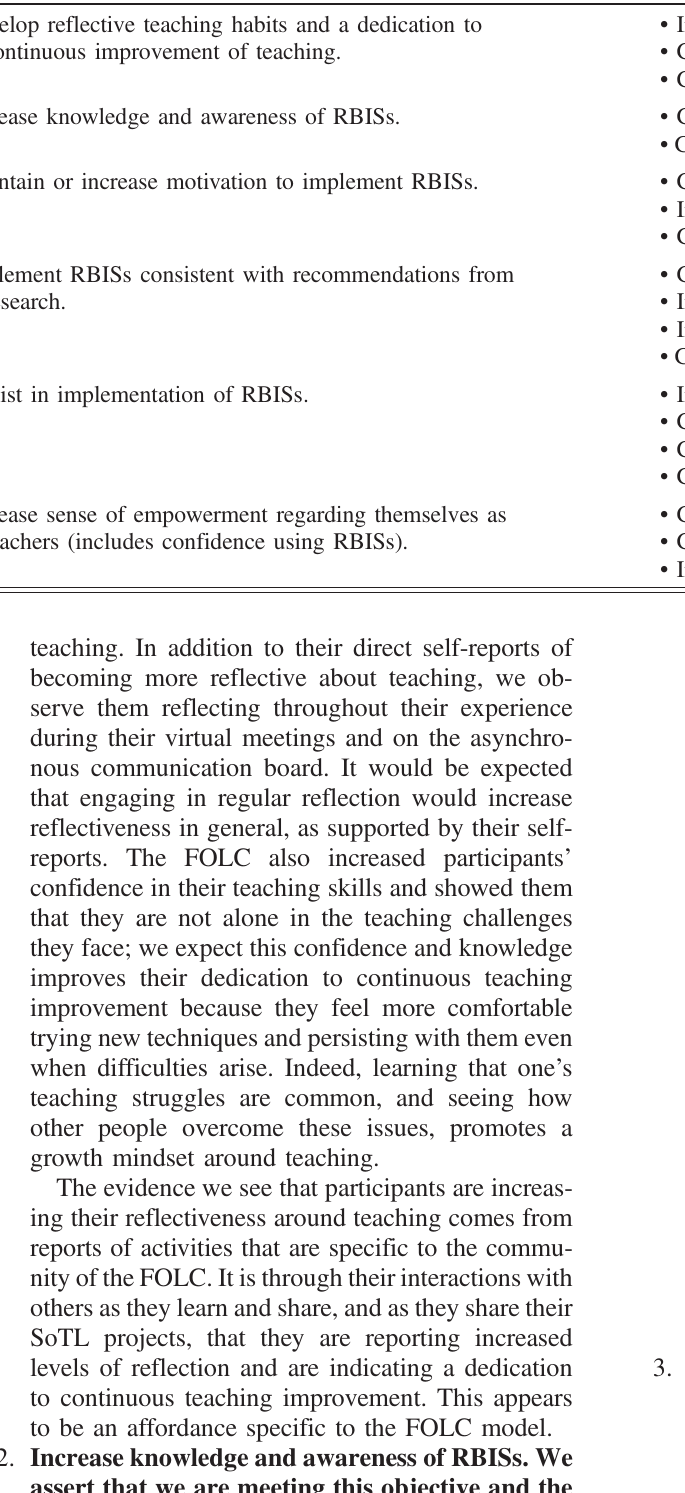
Reported FOLC impacts associated with learning objectives